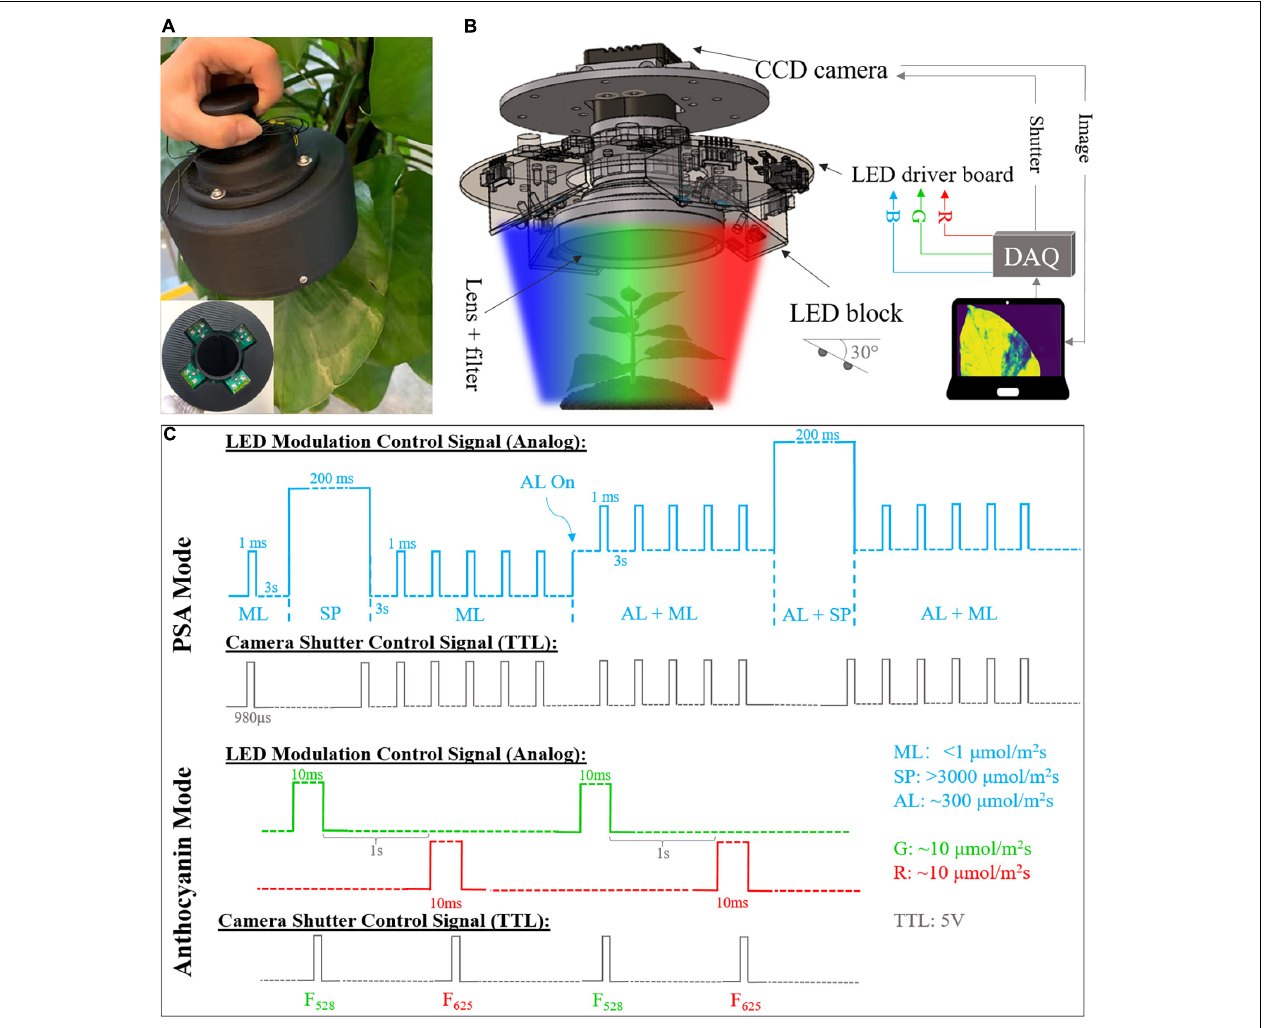
FIGURE 1 | (A) Photograph of the developed compact fluorescence imager. Side view and front view (inset). (B) System diagram and inner structure of fluorescence imager. DAQ, data acquisition. (C) Timing diagram of light emitting diode (LED) modulation and camera shutter control signals for photosynthetic activity monitoring with blue LEDs. ML, measuring light; SP, saturation pulse; AL, actinic light; TTL, transistor–transistor logic. Note that the timing diagram is for illustration purpose only. The pulse widths and amplitudes are not presented in right scale due to limited space.